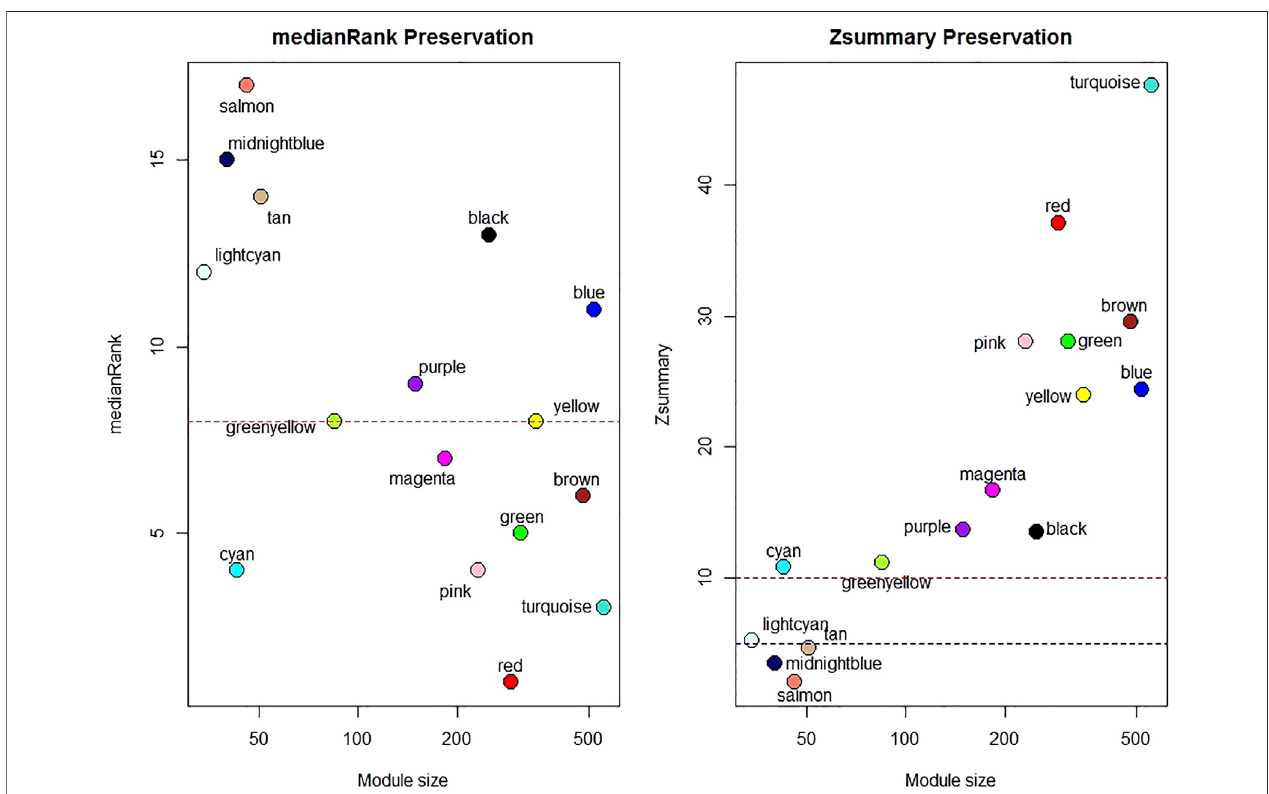
FIGURE2| MedianrankandZ-summarystatisticsforpreservationofmodulesfromthepost-vitaminDnetworkinthepre-vitaminDnetwork.Z-statistic > 10strong evidence of preservation, 5 – 10 moderate evidence of preservation, 2 – 5 weak evidence of preservation and < 2 no evidence of preservation (Langfelder et al., 2011).